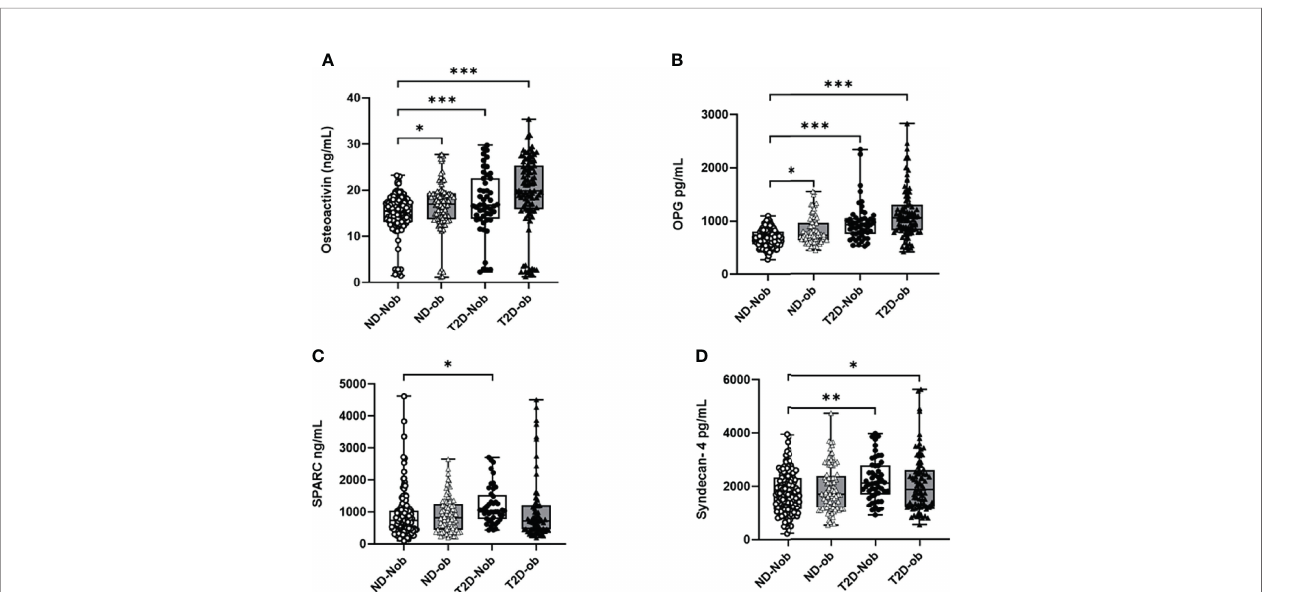
FIGURE 1 | Plasma levels of osteogenic factors Comparing ND to T2D individuals classi fi ed on the basis of obesity. (A) Osteoactivin, (B) Osteoprotegerin (OPG), (C) Osteonectin (SPARC), (D) Syndecan-4. Plasma levels of various osteogenic factors was determined using a multiplex bone panel. Diabetes was de fi ned by fasting plasma glucose ≥ 126mg/L (7 mmol/L). Obesity was de fi ned based on BMI, where participants with BMI > 30 kg/m2 were considered ob and those with BMI between 20 and 30 kg/m2 were considered Nob. Statistical assessment was considered statistically signi fi cant at *p < 0.05, **p ≤ 0.01, ***p < 0.001.